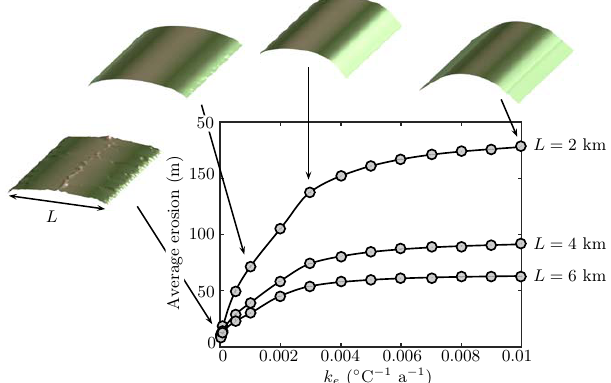
Figure 8. Mean accumulated frost-driven erosion after 4Myr for different values of k e (frost-cracking scaling factor). Results shown are for the intermediate climate model with − 6 < MAT < 0 ◦ C. The three curves are for model grids of different widths. The landscape is steepest for small L . Frost cracking increases with k e when ero- sion is production-limited. The three curves reach asymptotic levels for larger k e values because erosion becomes transport-limited. The insets show some of the modelled summit flats after 4Myr. The cur- vature and slope of the summit flats depend on the rates of erosion because slopes contribute to the scaling of sediment transport. Tors and bedrock ridges are stable phenomena in the left-most landscape where erosion is slow and